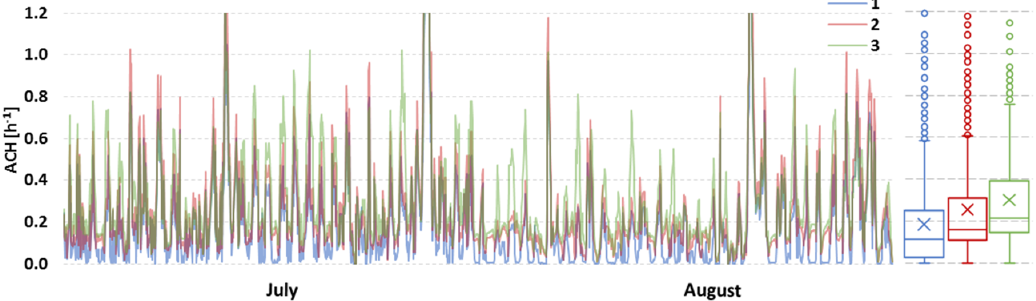
Figure 5. Hourly averaged ACH for the simulated period and boxplot representation in the three modeled scenarios with natural ventilation conditions; scenarios—1 (blue), 2 (red), 3 (green).